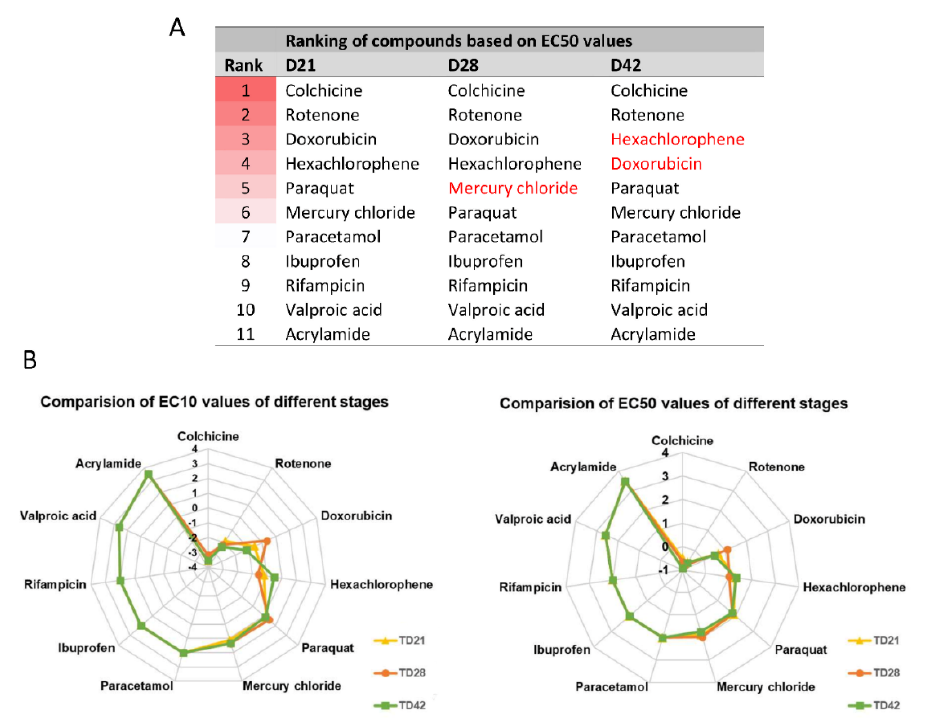
Figure 8. Comparison of the toxic effect of compounds. ( A ) Ranking of compounds at different differentiation stages based on EC50 values. Darker background color represents higher toxicity, while white color represents non-toxic compounds. ( B ) Radar chart showing the comparison of compounds based on the order of EC10 or EC50 values, at various differentiation stages (yellow line with rectangular: D21; orange line with circle: D28; green line with square: D42) (see also EC values in Table S4). Concentration values are presented in log µM.